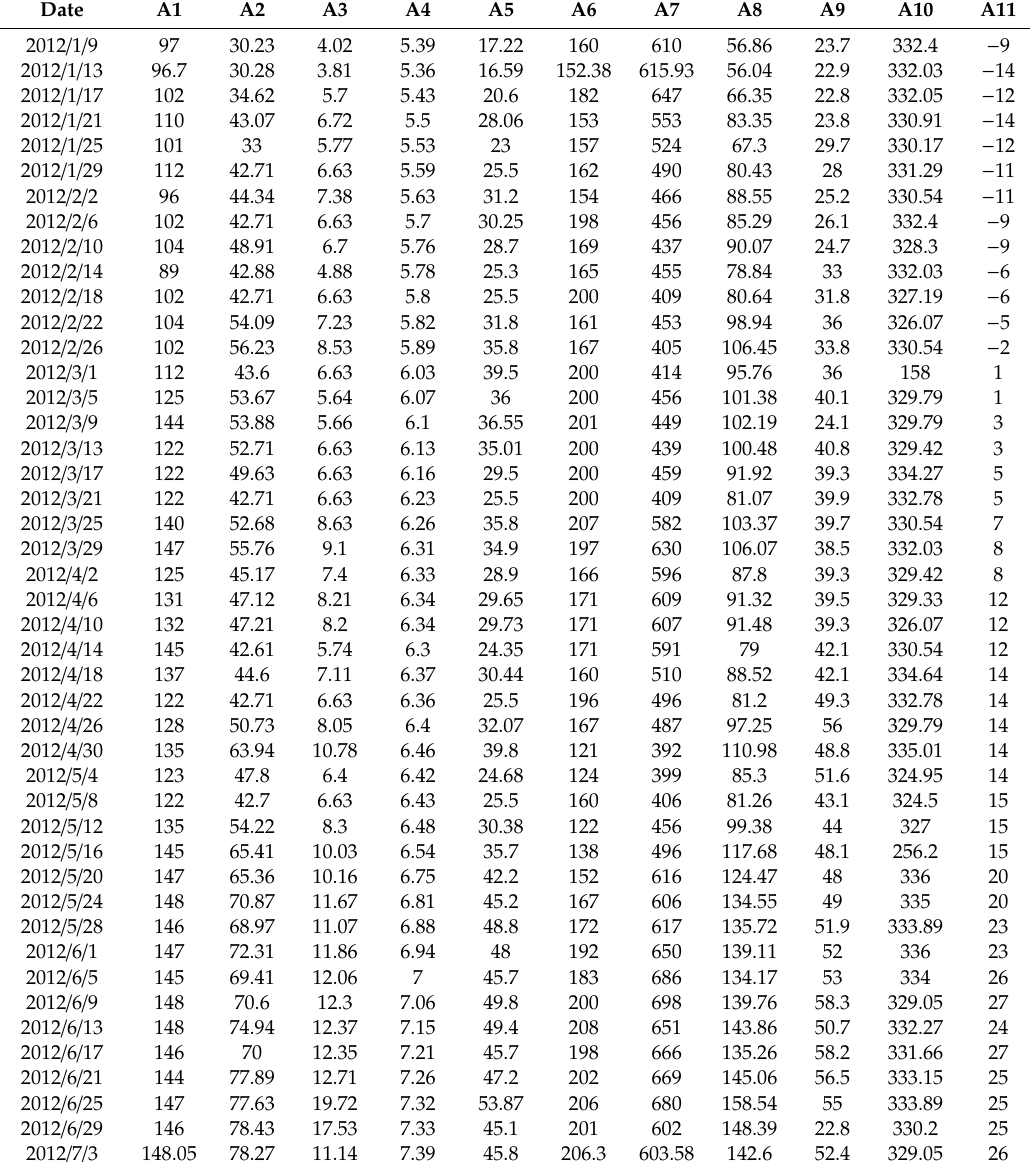
Table 1. Distribution of transformer sample